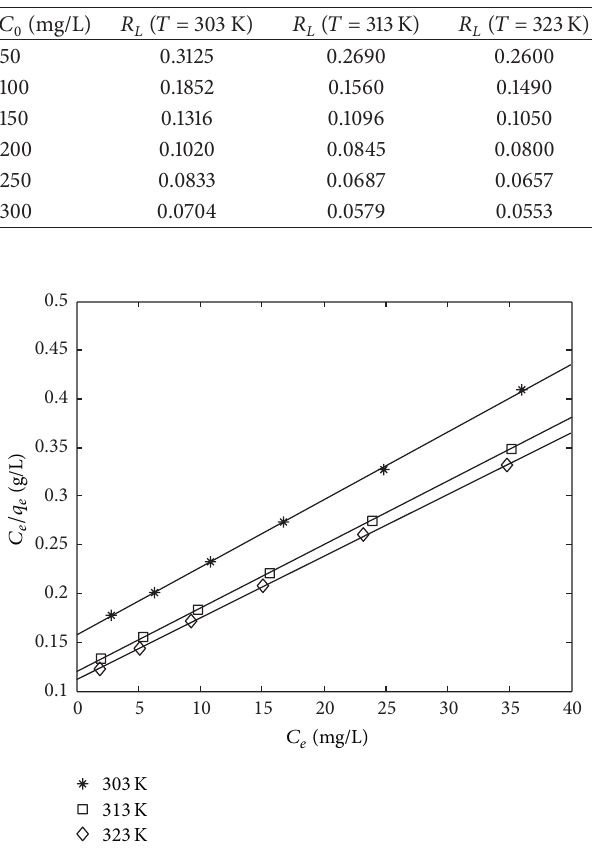
Figure 7: Linearized Langmuir isotherm at different temperatures ( 𝑀 : 0.3 g; pH: 6; agitation rpm: